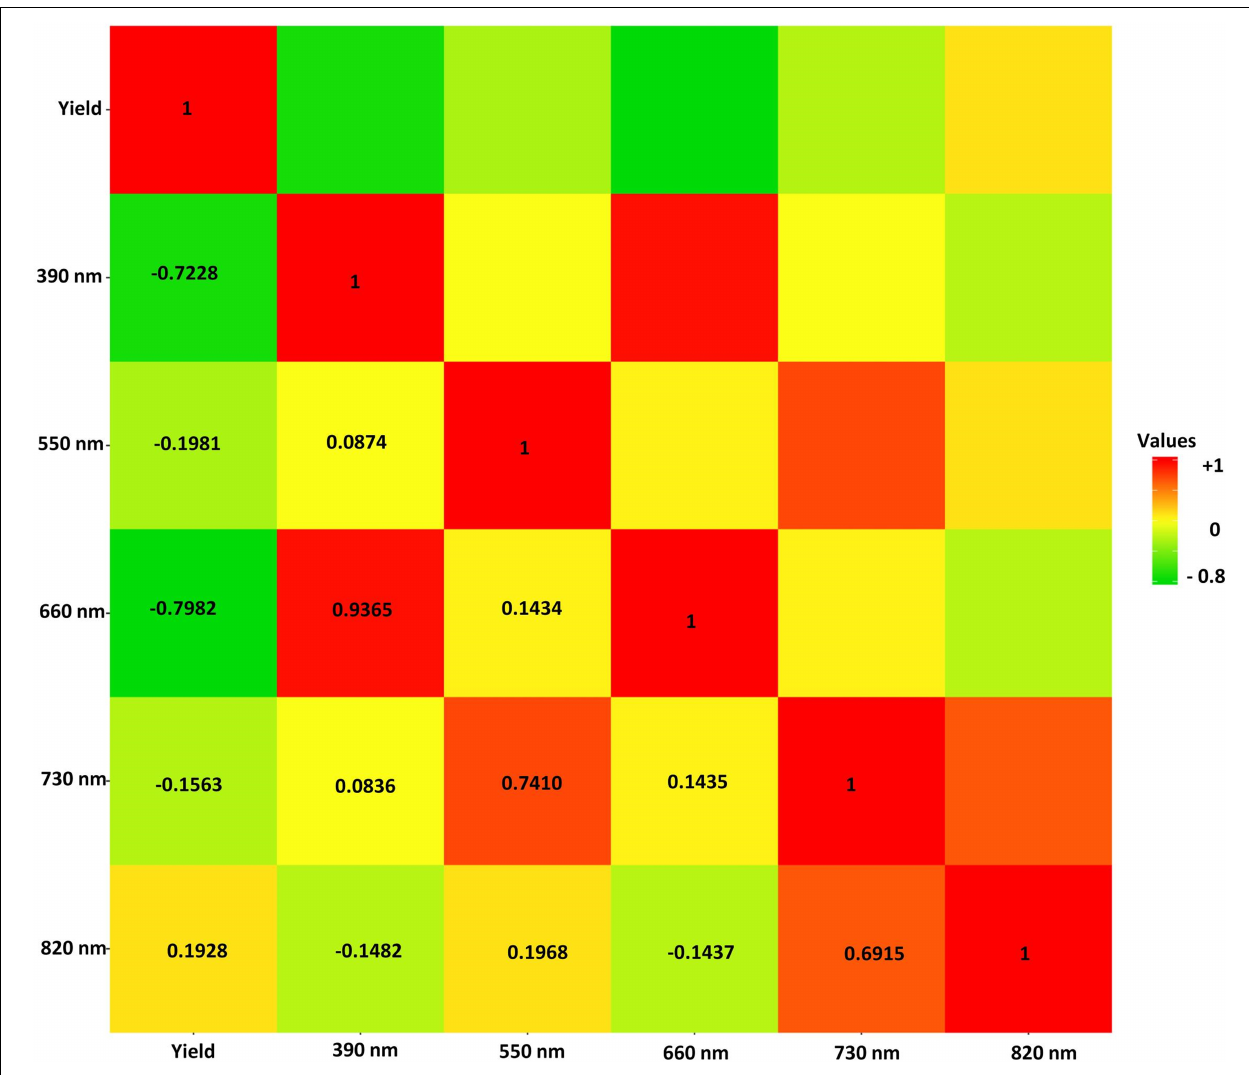
micronutrient concentrations) were linked to